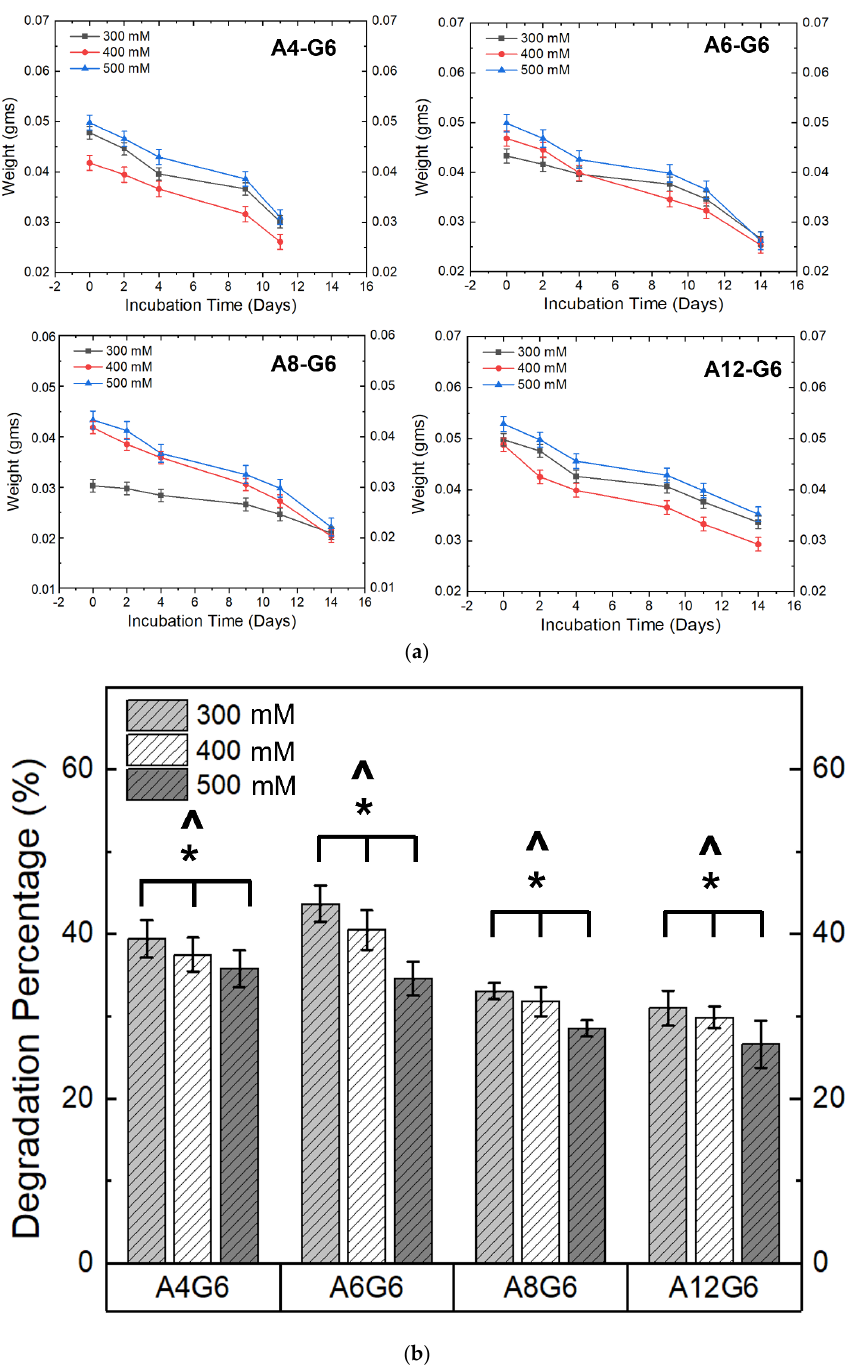
Figure 9. ( a ) Weight distribution of the alginate–gelatin scaffolds over the incubation period indicating the degradation kinetics of different printed scaffolds over time. ( b ) Degradation percentage of the different printed scaffolds over 14 days. * indicates that at 0.05 level (two-way ANOVA), the variation in the crosslinking concentrations had a significant effect on the degradation percentage of the scaffolds. ˆ indicates that at the 0.05 level (two-way ANOVA), varying alginate concentrations had a significant effect on the degradation percentage of the